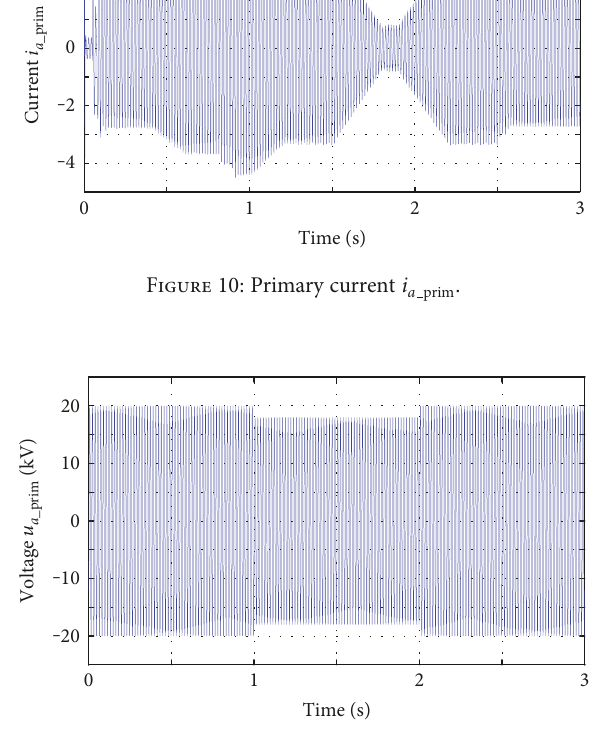
Figure 11: Bus voltage decrease.